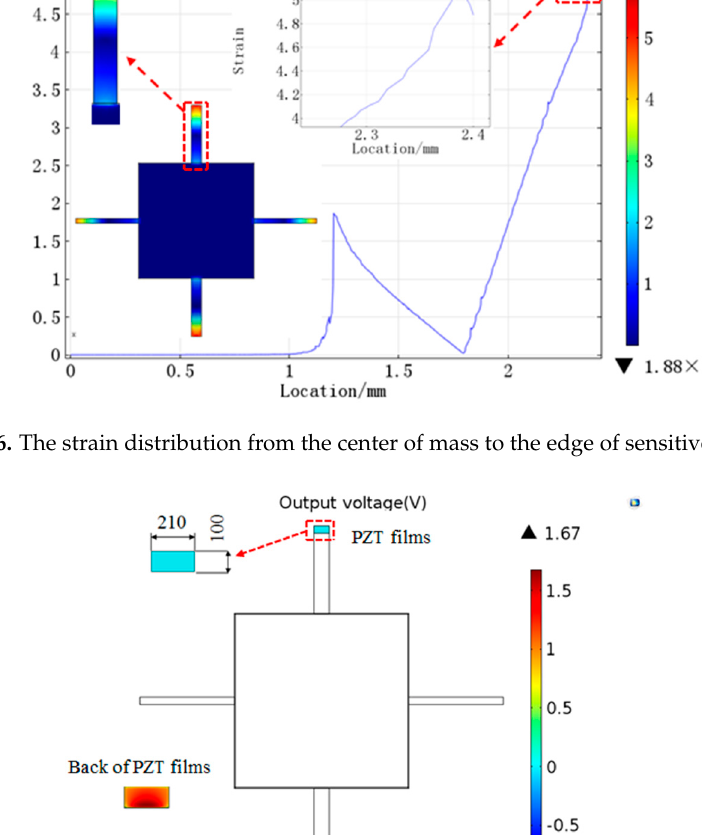
Table 1. The result of the modal